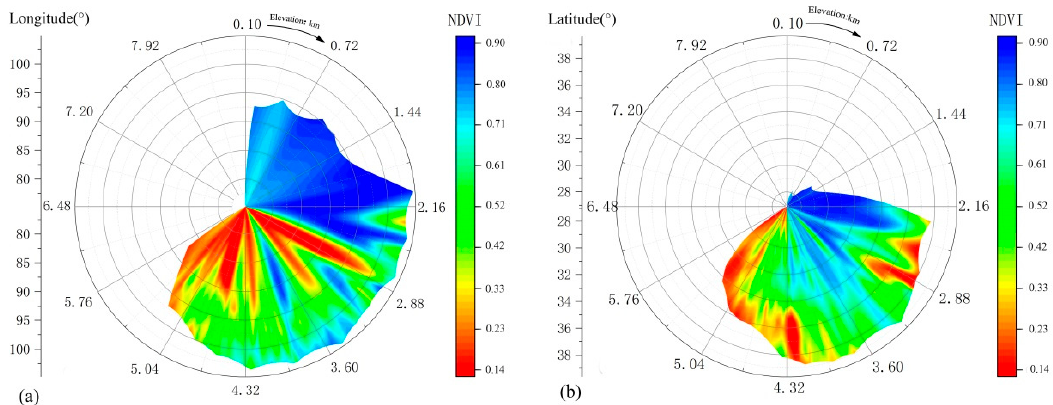
Figure 4. Spatial distribution of multi-year mean of NDVI in the growing season in TP from 2001 to 2017. ( a ) Statistics based on longitude and altitude, ( b ) Statistics based on latitude and altitude.